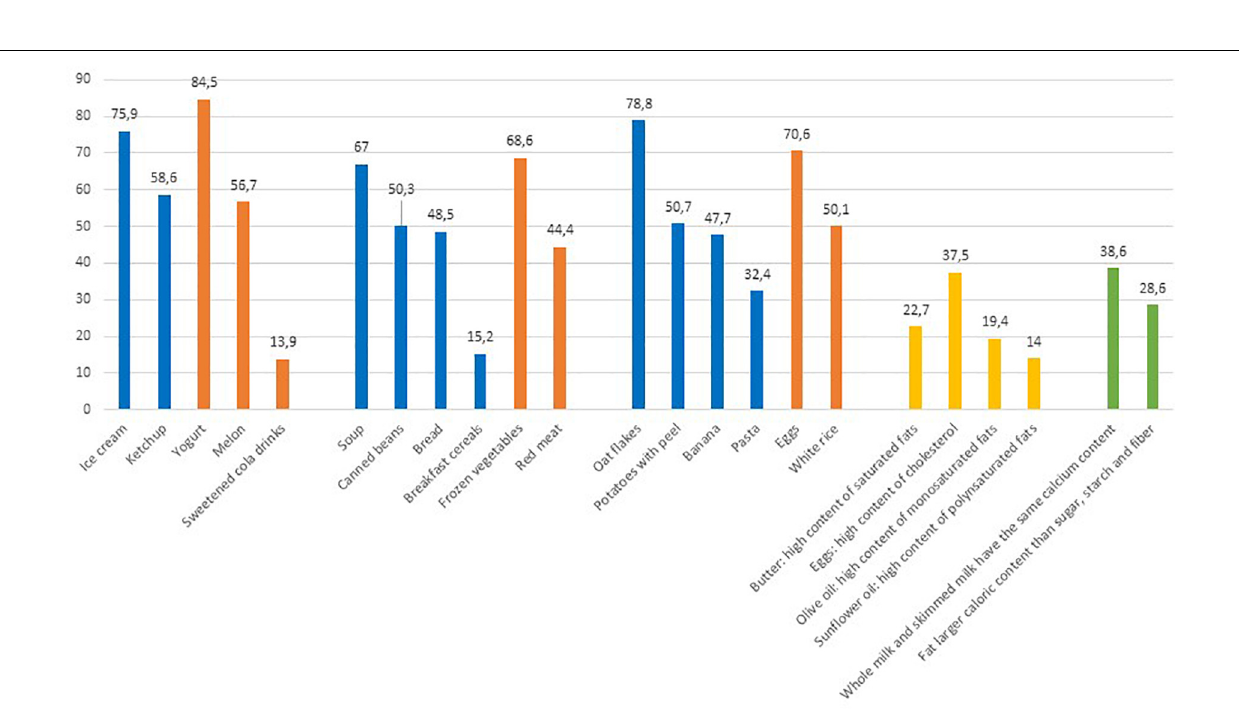
Frontiers in Nutrition |